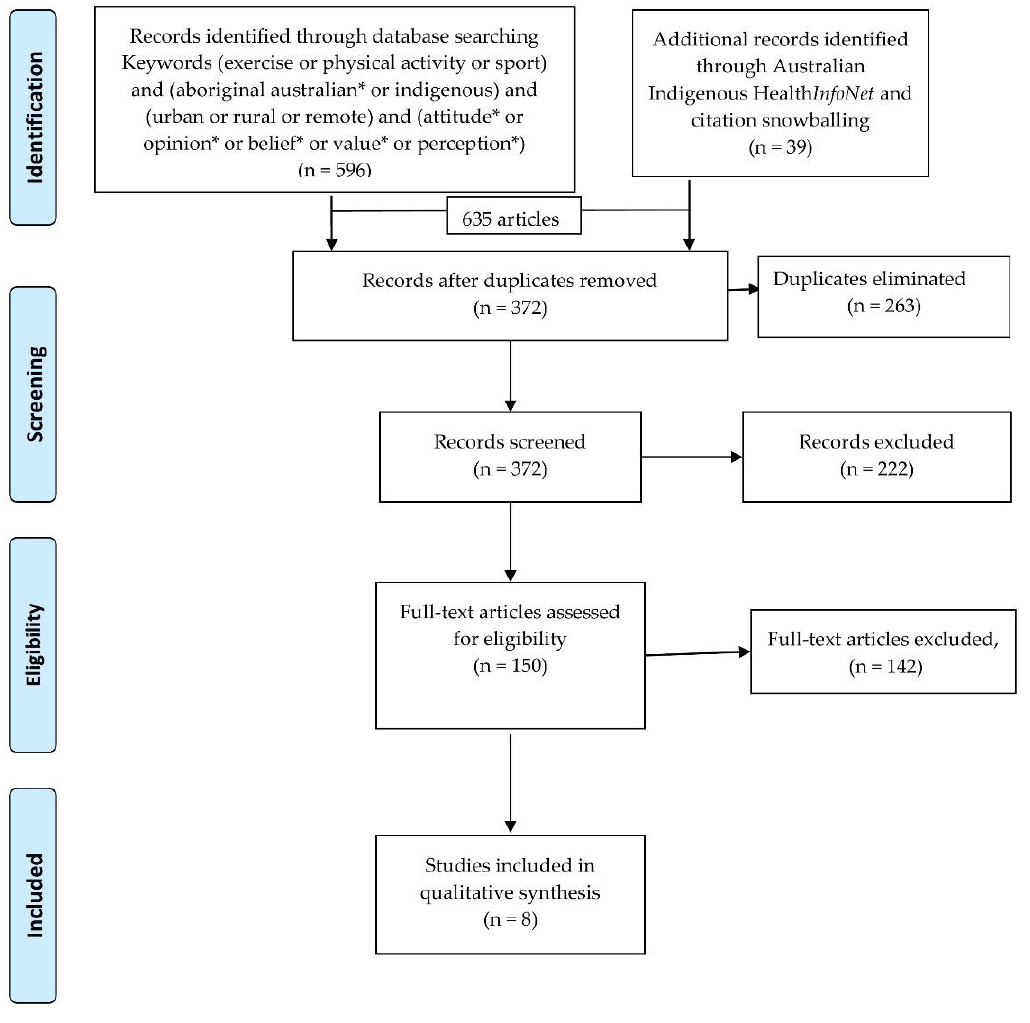
Figure 1. PRISMA Flow diagram showing systematic approach to literature search [12].